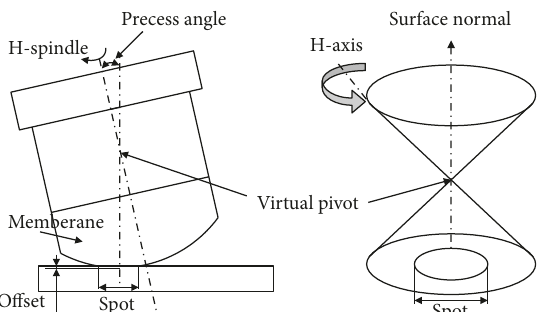
Figure 2: Bonnet polishing principle.